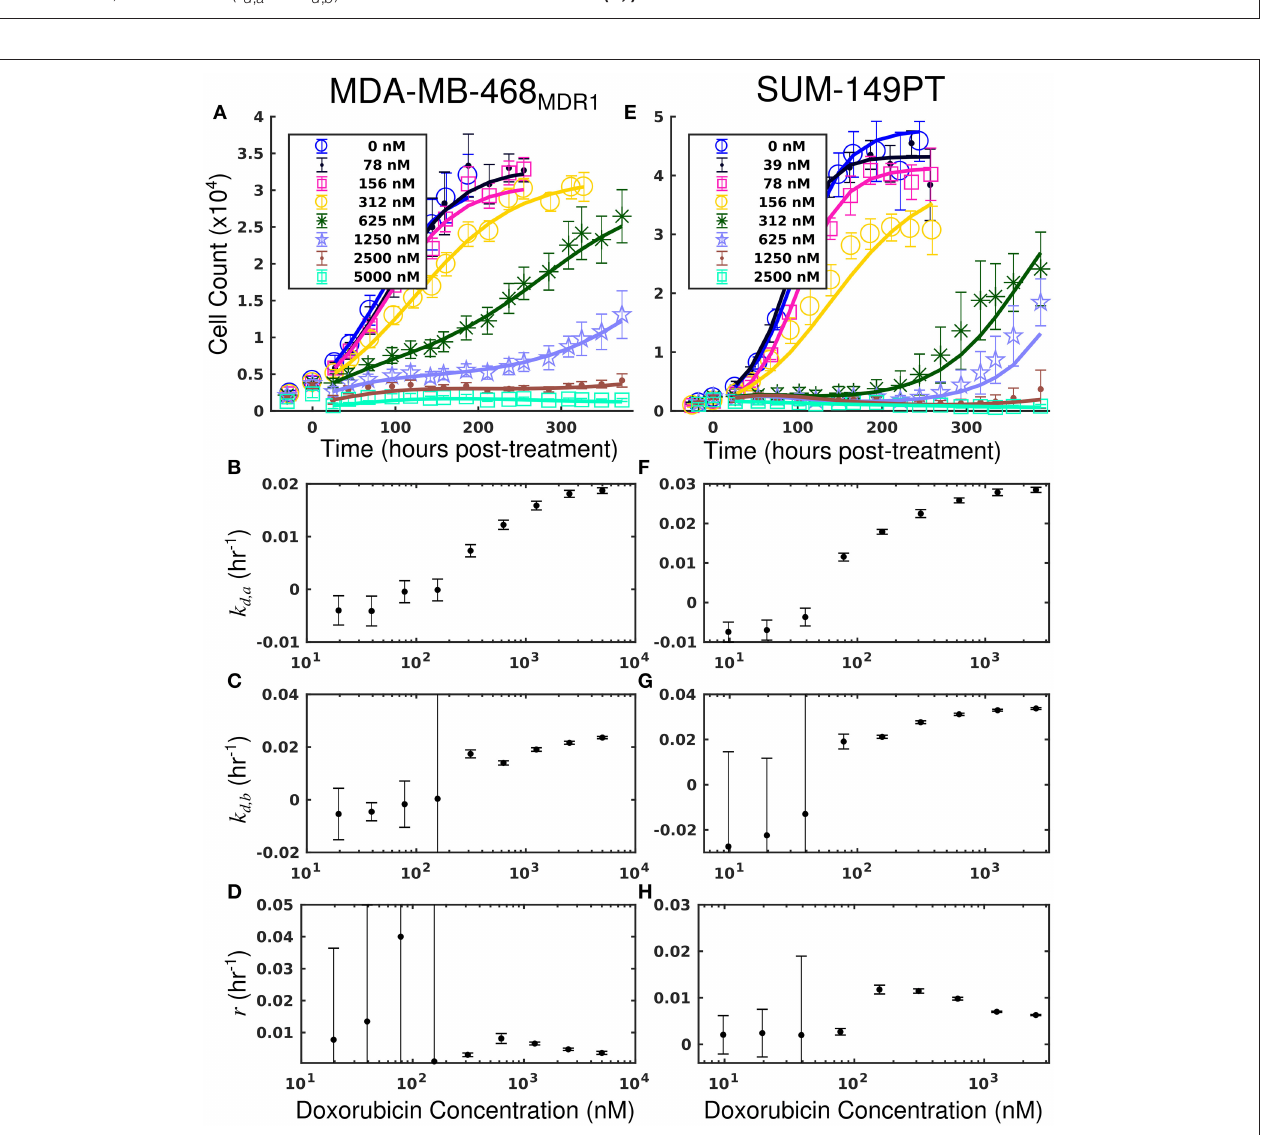
FIGURE 2 | (C) , consistent with MDR1 inhibition by TQR. Cell counts of MDA-MB-468 MDR1 following combination treatment with TQR and doxorubicin are show in panels (E-G) . In each plot, a fixed concentration of doxorubicin is applied with variable TQR concentrations. These counts are fit with Equations (4–6) as described in section Model Fits, and the best-fit model is overlaid on the cell counts [smooth lines in panels (E–G) ]. Error bars represent the 95% CI from six experimental replicates for each treatment condition. Model parameters with corresponding 95% CI are shown in (H–J) as a function of TQR concentration. For each doxorubicin